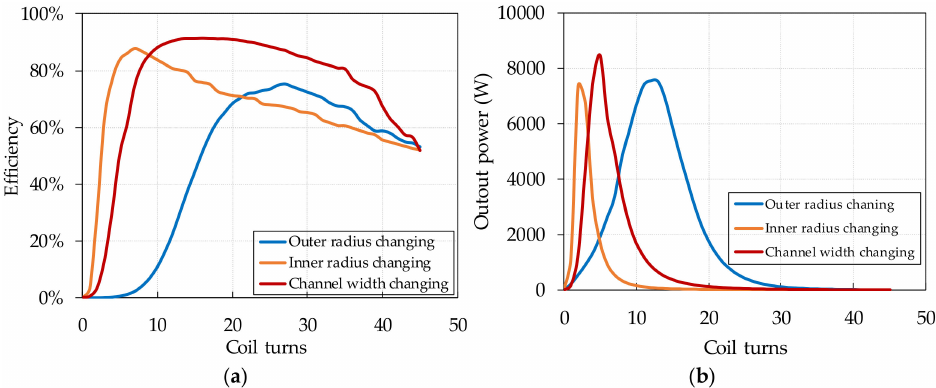
Figure 18. Coil-system efficiency comparison among previous three methods. ( a ) Coil-system efficiency; ( b ) Output power.